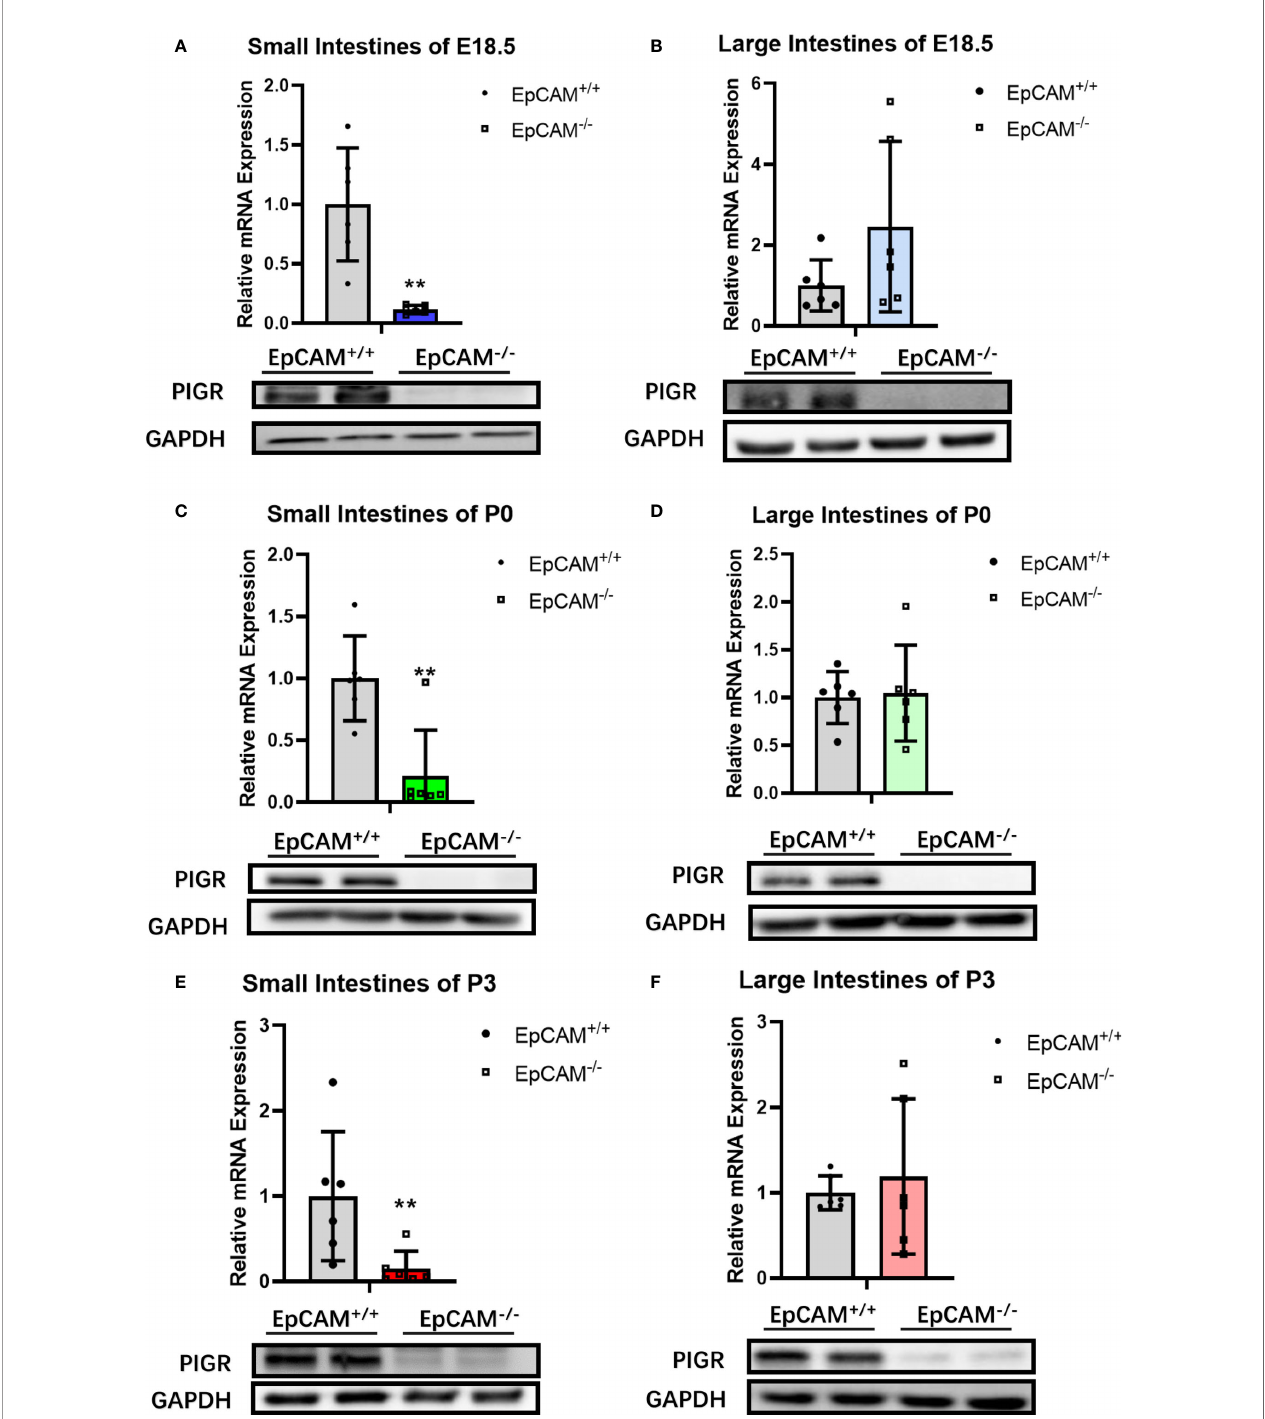
FIGURE 5 | EpCAM de fi ciency caused the downregulation of pIgR in the intestines of mice. (A) The mRNA (n=6) and protein (n=3) expression levels of pIgR in the small intestines from WT and EpCAM -/- embryos at E18.5 stage. (B) The mRNA (n=6) and protein (n=3) expression levels of pIgR in the large intestines from WT and EpCAM -/- embryos at E18.5 stage. (C) The mRNA (n=6) and protein (n=3) expression levels of pIgR in the small intestines from WT and EpCAM -/- pups at P0 stage. (D) The mRNA (n=6) and protein (n=3) expression levels of pIgR in the large intestines from WT and EpCAM -/- pups at P0 stage. (E) The mRNA (n=6) and protein (n=3) expression levels of pIgR in the small intestines from WT and EpCAM -/- pups at P3 stage. (F) The mRNA (n=6) and protein (n=3) expression levels of pIgR in the large intestines from WT and EpCAM -/- pups at P3 stage. ** p < 0.01, as determined by Mann – Whitney U test. All error bars represent